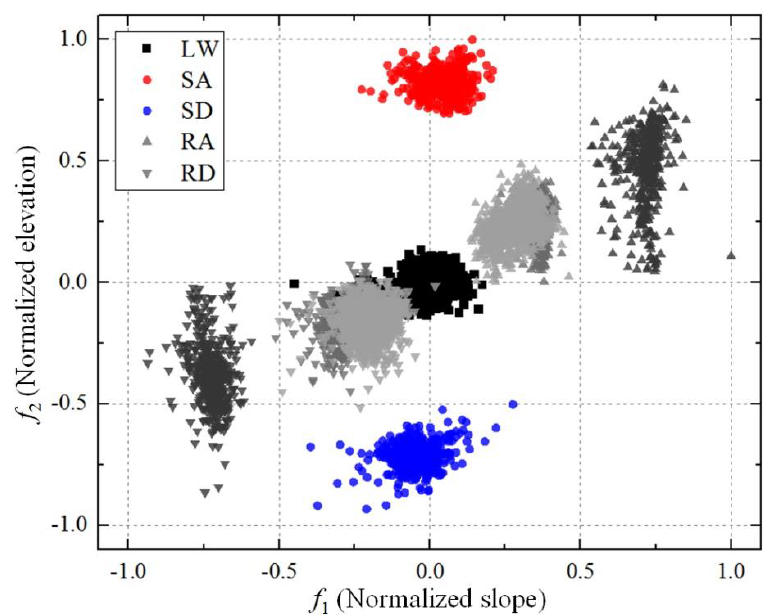
ff erent slopes are colored